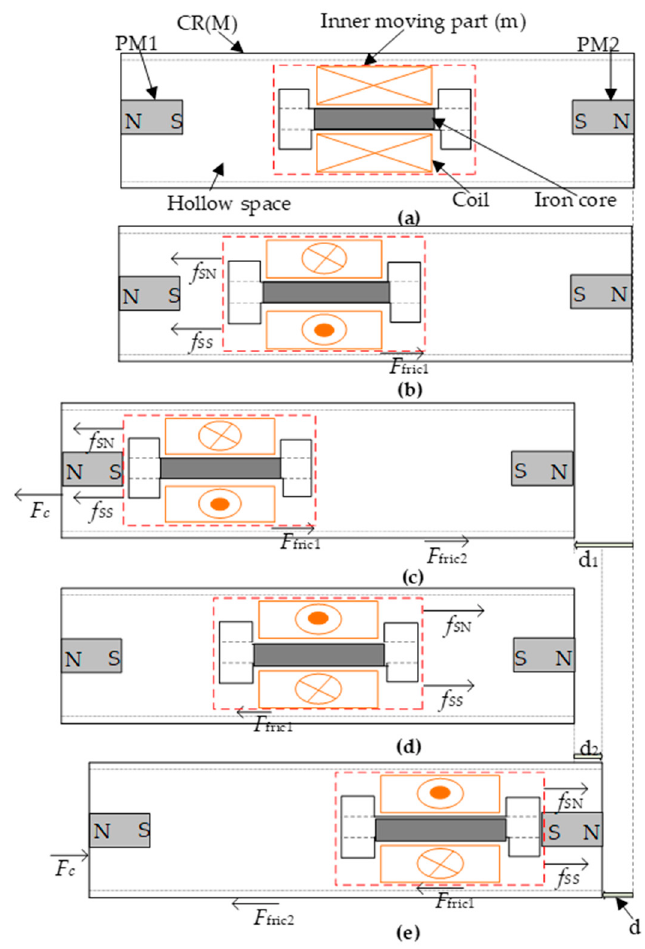
Figure 2. Representation of di ff erent steps of the capsule robot (CR) locomotion mechanism: ( a ) original position, ( b ) coil begins to move towards PM1, ( c ) coil collides to PM1 and drives the capsule to move forward, ( d ) coil moves back to PM2, ( e ) coil collides to PM2 and drives the capsule to move backward.